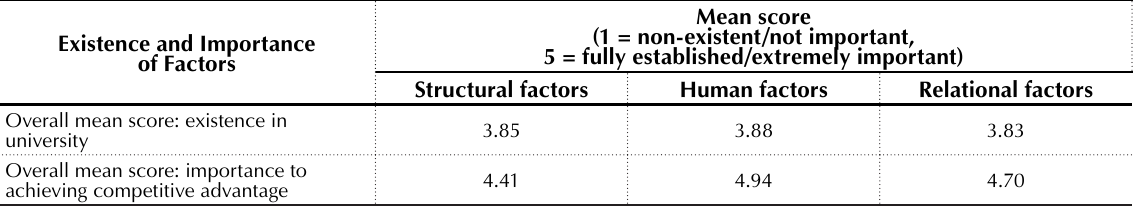
Table 4. Summary of existence and importance of factors Existence and Importance of